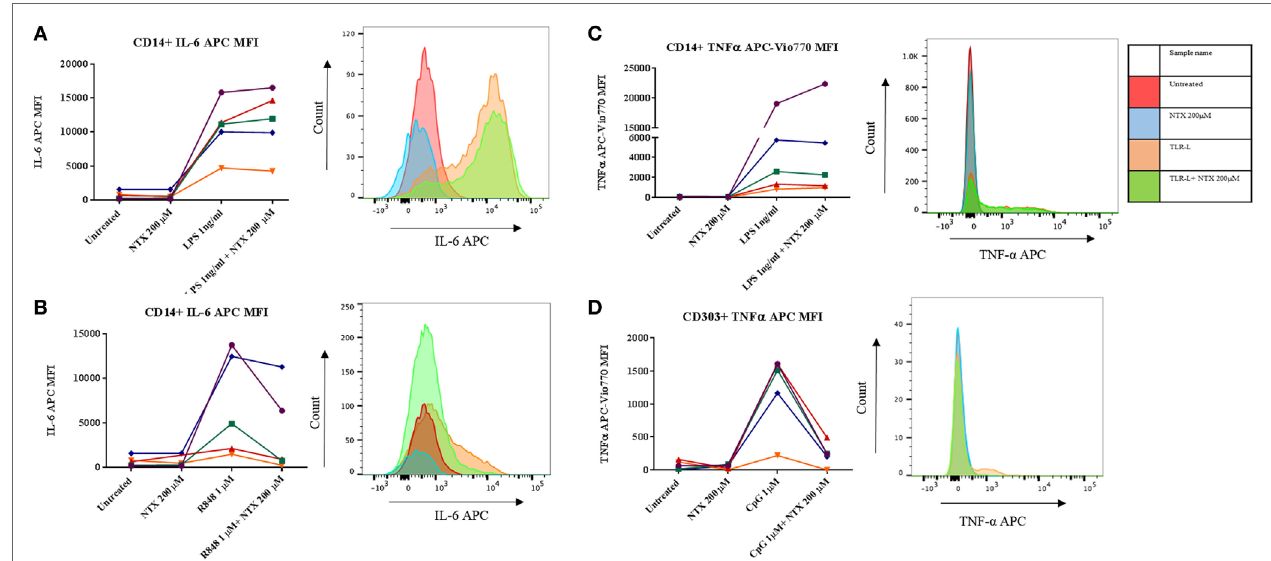
FigUre 2 | Intracellular cytokine staining for TNF α and IL-6 in monocytes and plasmacytoid dendritic cells. 1 × 10 6 peripheral blood mononuclear cells (PBMC) were incubated with either LPS 1 ng/ml (a,c) , R848 1µM (B) , or CpG 1µM (D) and 200 µM naltrexone for 6 h in the presence of brefeldin A for 4 of those hours. After 6 h, PBMC were stained using antibody panel shown in Figure S4 in Supplementary Material and stained for either intracellular IL-6 or TNF- α . Results show the mean fluorescence intensity (MFI) of IL-6 or TNF- α within that subset from 5 donors. Histograms are representative of 5 independent